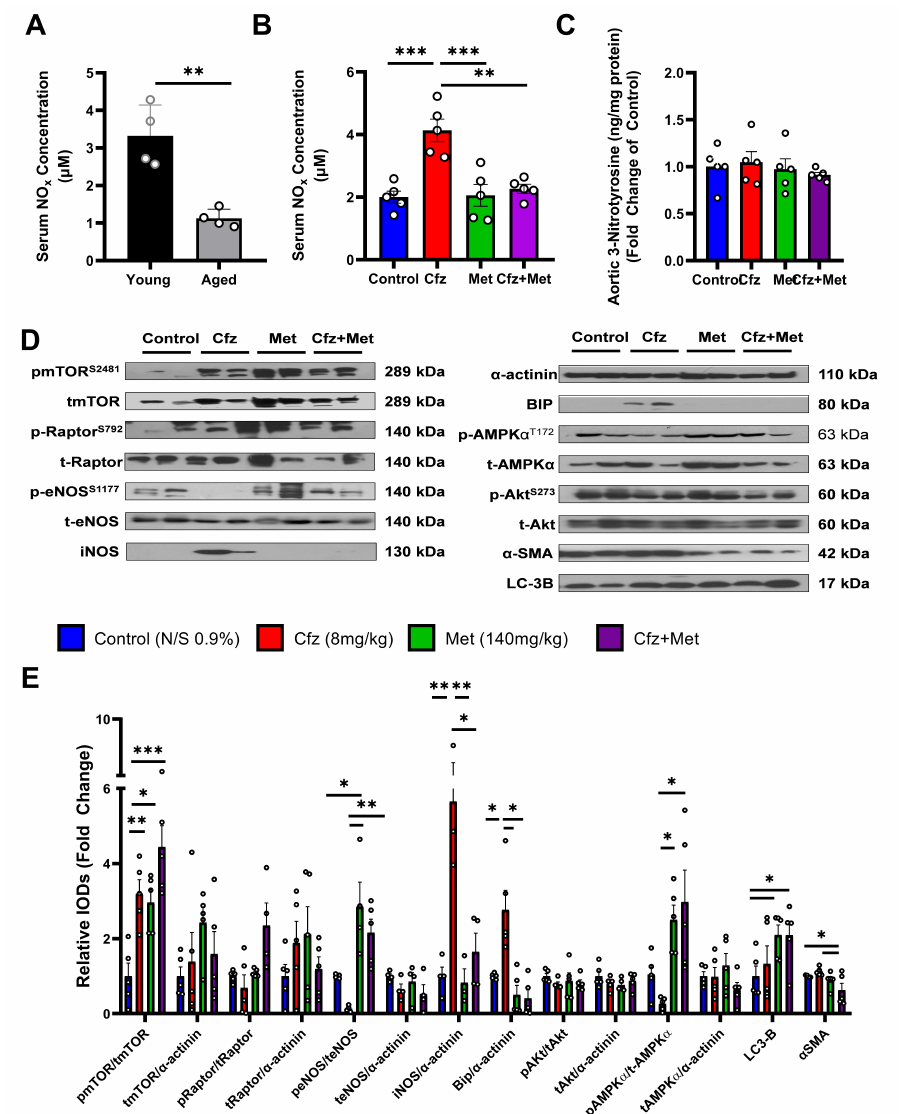
Figure 5. Carfilzomib and metformin coadministration induced LC3-B-dependent autophagy in the aortas of aged mice, while Cfz increased serum NO x content without leading to a nitro-oxidative stress in the aortas. Graphs of serum NO x concentration ( µ M) of ( A ) young (3–4 months of age) and aged (15–17 months of age) mice ( n = 4 per group). ( B ) Aged mice treated with carfilzomib (Cfz), metformin (Met) or the combination of the drugs ( n = 5 per group). ( C ) Graph of aortic 3-nitrotyrosine (3-NT; ng / mg protein; fold change of the control) of aged treated mice ( n = 5 per group). ( D ) Representative Western blot images of aged murine aortas and ( E ) relative densitometry analysis of the selected proteins and their phosphorylated forms ( n = 5 per group; * p < 0.05, ** p < 0.01, *** p < 0.005, one way ANOVA, Tukey’s multiple comparison test). Data are presented as mean ± SEM and individual values are presented as scatter column graphs. Blue lines / columns represent the control (Normal Saline; NS 0.9%), red lines / columns represent Cfz (8 mg / kg, ip), green lines / columns Met (140 mg / kg, per os) and purple lines / columns Cfz + Met (8 mg / kg, ip and 140 mg / kg, per os, respectively) in the 6 days protocol (subacute protocol). Cfz, Carfilzomib; Met,